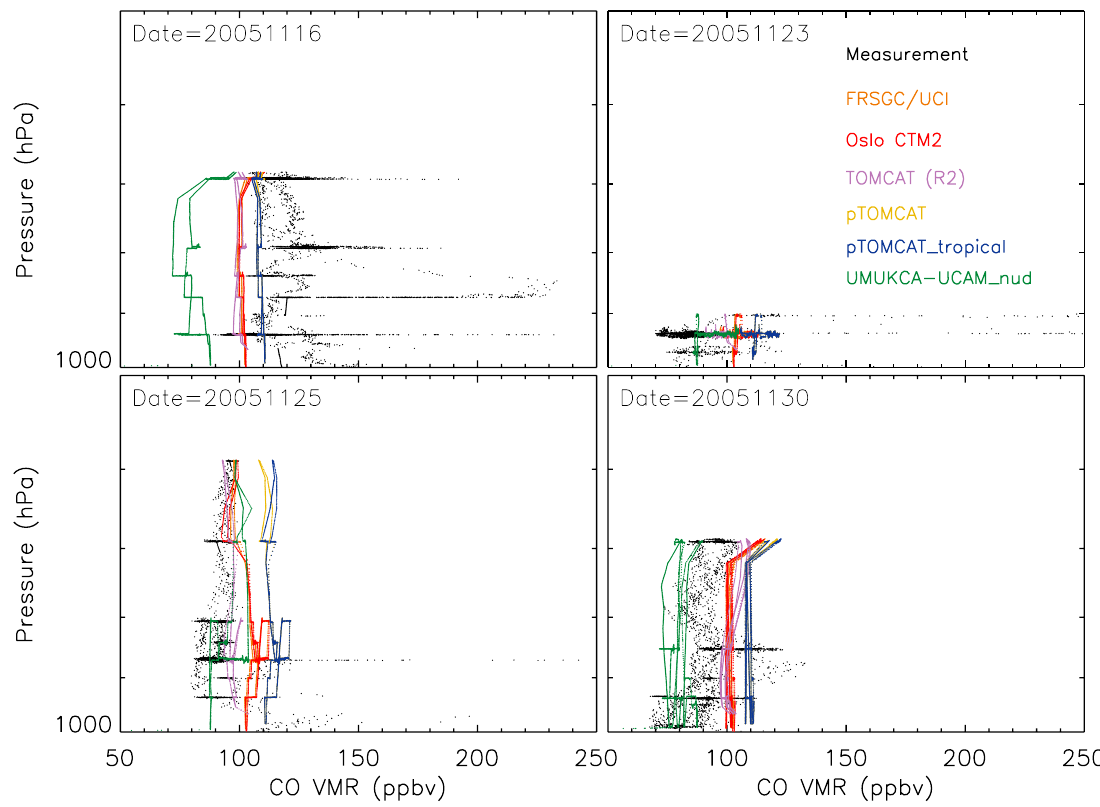
Fig. 10. A comparison between modelled and measured CO mixing ratios along the Dornier flight track for 16, 23, 25 and 30 November 2005. The measurements were made during the Active campaign in Darwin,